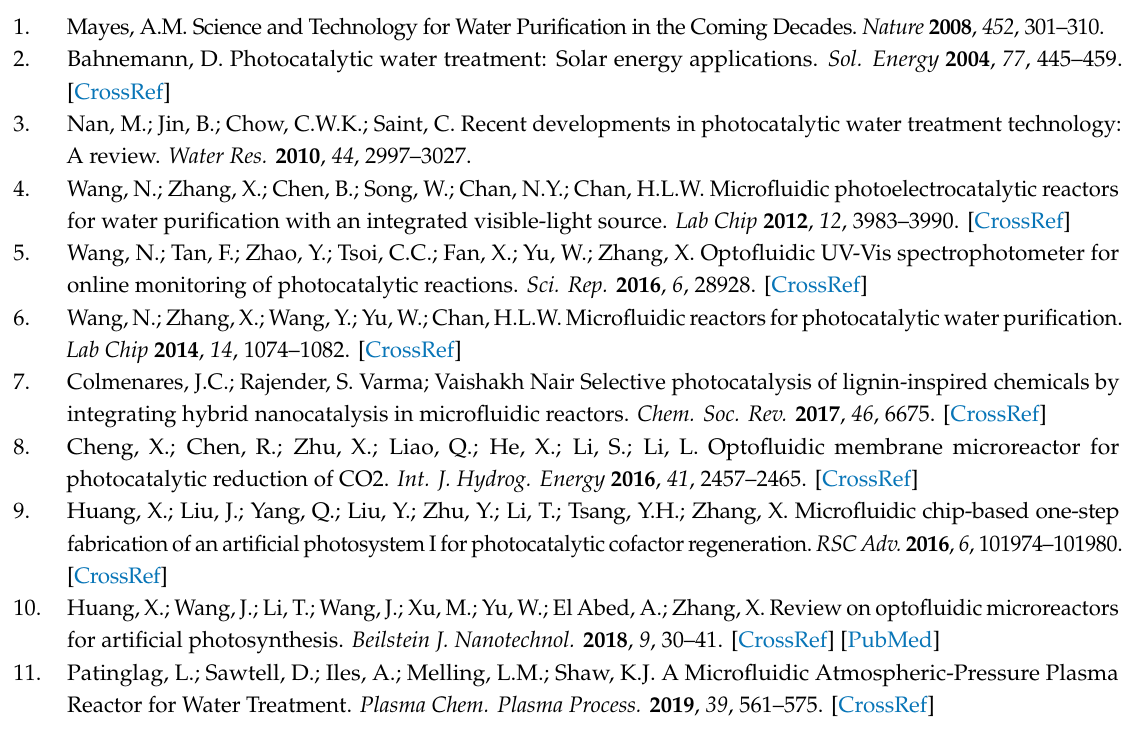
Figure S1: To clearly understand the morphology and distribution of the photocatalysts on the filter paper, we characterized the sample by the SEM, Figure S2: Standard curve of MB solution, showing the relationship between concentration and